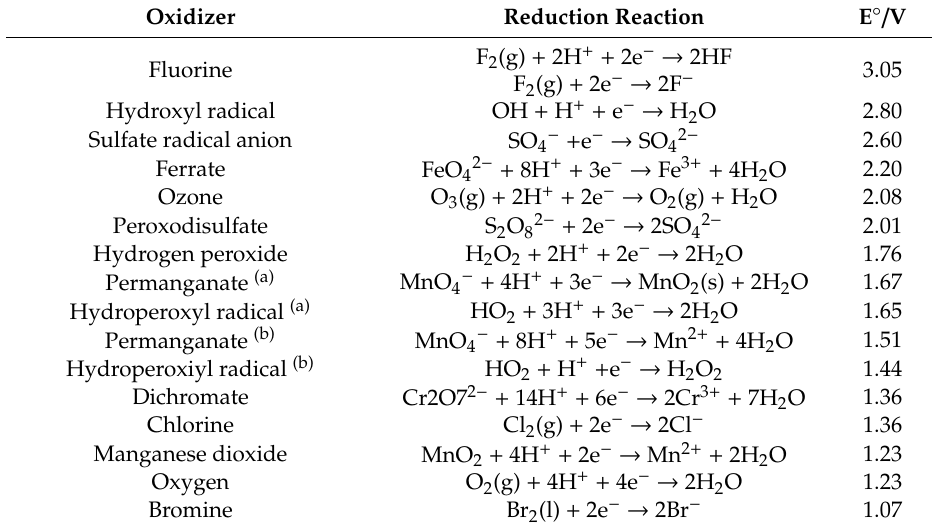
Table 2. Standard reduction potentials in aqueous medium of the most commonly used oxidizing agents.